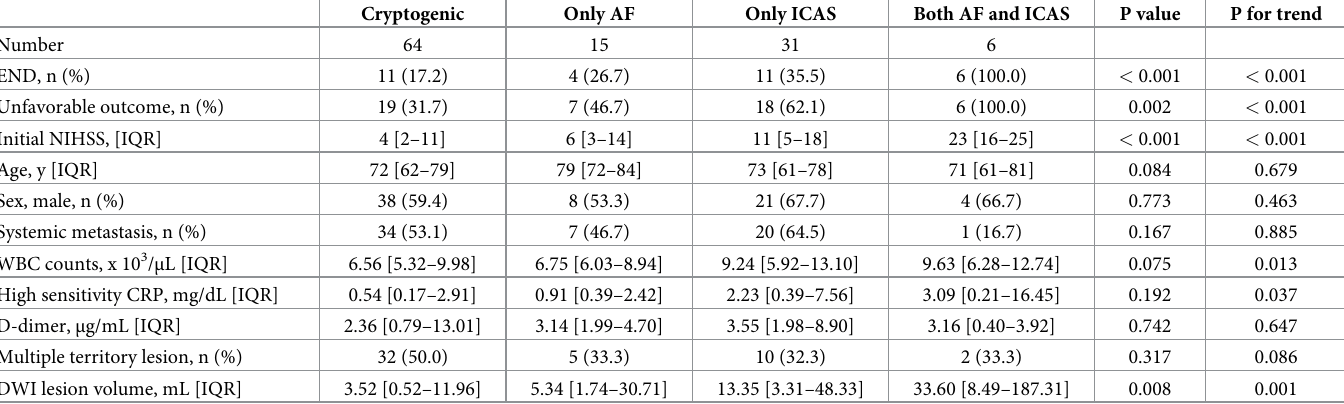
Table 5. Comparisons of characteristics in ischemic stroke patients with active cancer according to the presence or absence of atrial fibrillation and intracranial